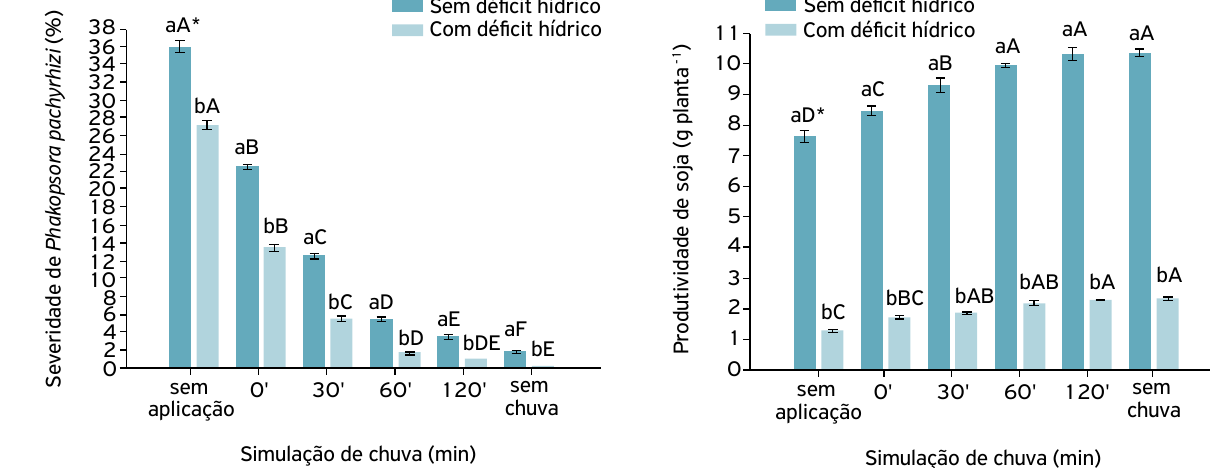
Figura 3. Produtividade de soja (g planta ‑1 ) na interação entre regimes hídricos e intervalos de simulação de chuva após a aplicação de fungicida. Itaara – RS,